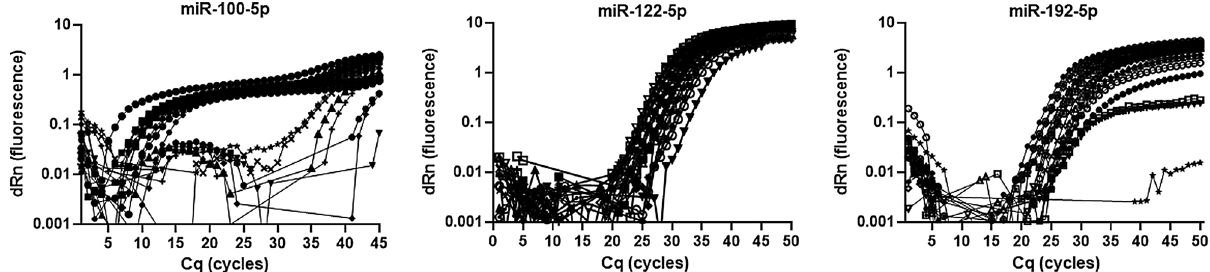
Figure 1. RT-qPCR TaqMan assay measurement of miR-100-5p, miR-122-5p, and miR-192-5p. Amplification TaqMan plots of representative plasma samples. In contrast to miR-122-5p and miR-192-5p, miR-100-5p was not detected by the commercial TaqMan assay. Measurements were set up in duplicate.